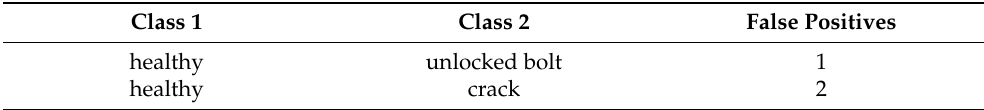
Table 9. False positives for damage detection (model